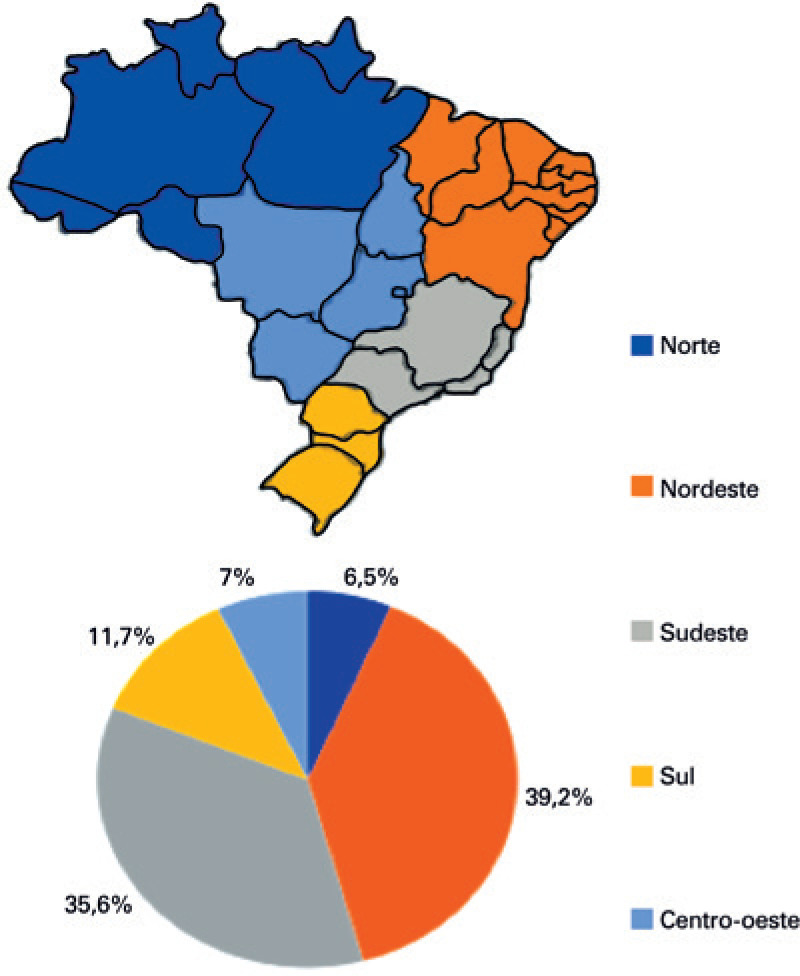
Distribuição das internações no Sistema Único de Saúde por diagnóstico de câncer de pênis, nas regiões geográficas do Brasil, de 1992 a 2017